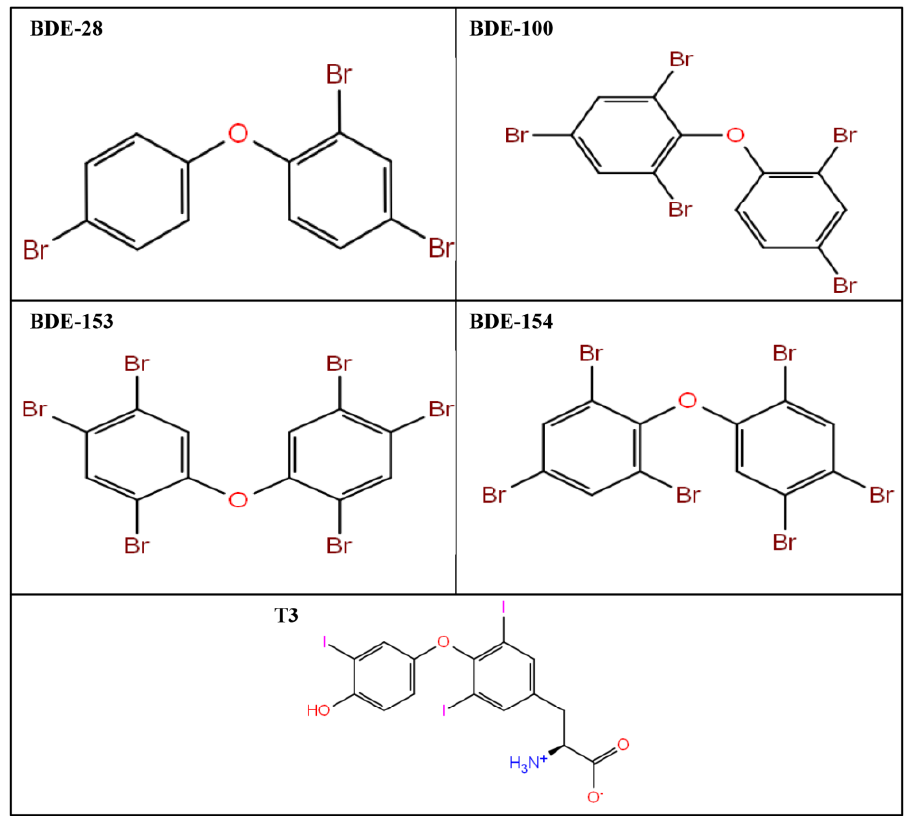
Figure 3. Two-dimensional structure of polybrominated diphenyl ethers (PBDEs) flame retardants: BDE-28, BDE-100, BDE-153, BDE-154, and a TRα native ligand, T3.